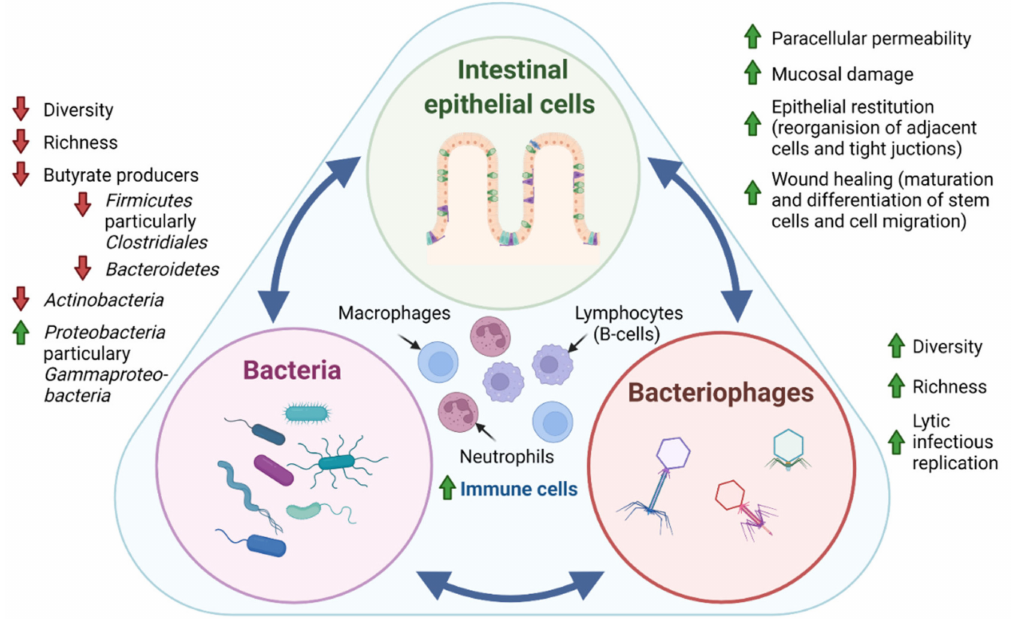
Figure 1. Tripartite relationship between the intestinal epithelial cells, bacteria, and bacterio- phages in IBD pathogenesis. In IBD pathogenesis, bacterial dysbiosis is characterized by decreased bacterial diversity (measure of the number of species in a community, and a measure of the abundance of each species) and richness (number of species in a community) evident by the depletion of the phyla Actinobacteria, Firmicutes , and Bacteroidetes and an enrichment of Proteobacteria . In contrast, studies generally suggest that intestinal bacteriophages, which are viruses that infect and replicate within bacteria, display increased diversity and richness. Interestingly, it has recently been suggested that the temperate phage population displays a shift from lysogenic to lytic replication in patients with IBD [44]. Where intestinal epithelial cells are known to directly regulate the secretion of mucus, antimicrobial peptides, and immune mediators through patterns recognition receptors (PRR), surpris- ing evidence also points towards direct communication between bacteriophages and epithelial cells by adhering to mucosal surfaces, apical-to-basolateral transcytosis, and by the direct delivery of proteins and nucleic acids to eukaryotic cells. Thus, the intestinal epithelial cell layer, intestinal bacteria, and bacteriophages exist in a dynamic tripartite—both mutualistic and parasitic—relationship. Further, sparse studies propose that fungal and protozoan microbiomes are also affected in IBD pathogenesis, displaying both altered diversity and composition. The mechanistic interplay between intestinal epithelial cells, bacteria, bacteriophages, as well as fungi and protozoa, has yet to be unraveled, but would potentially provide insight for future clinical applications of microbiota in IBD. Green